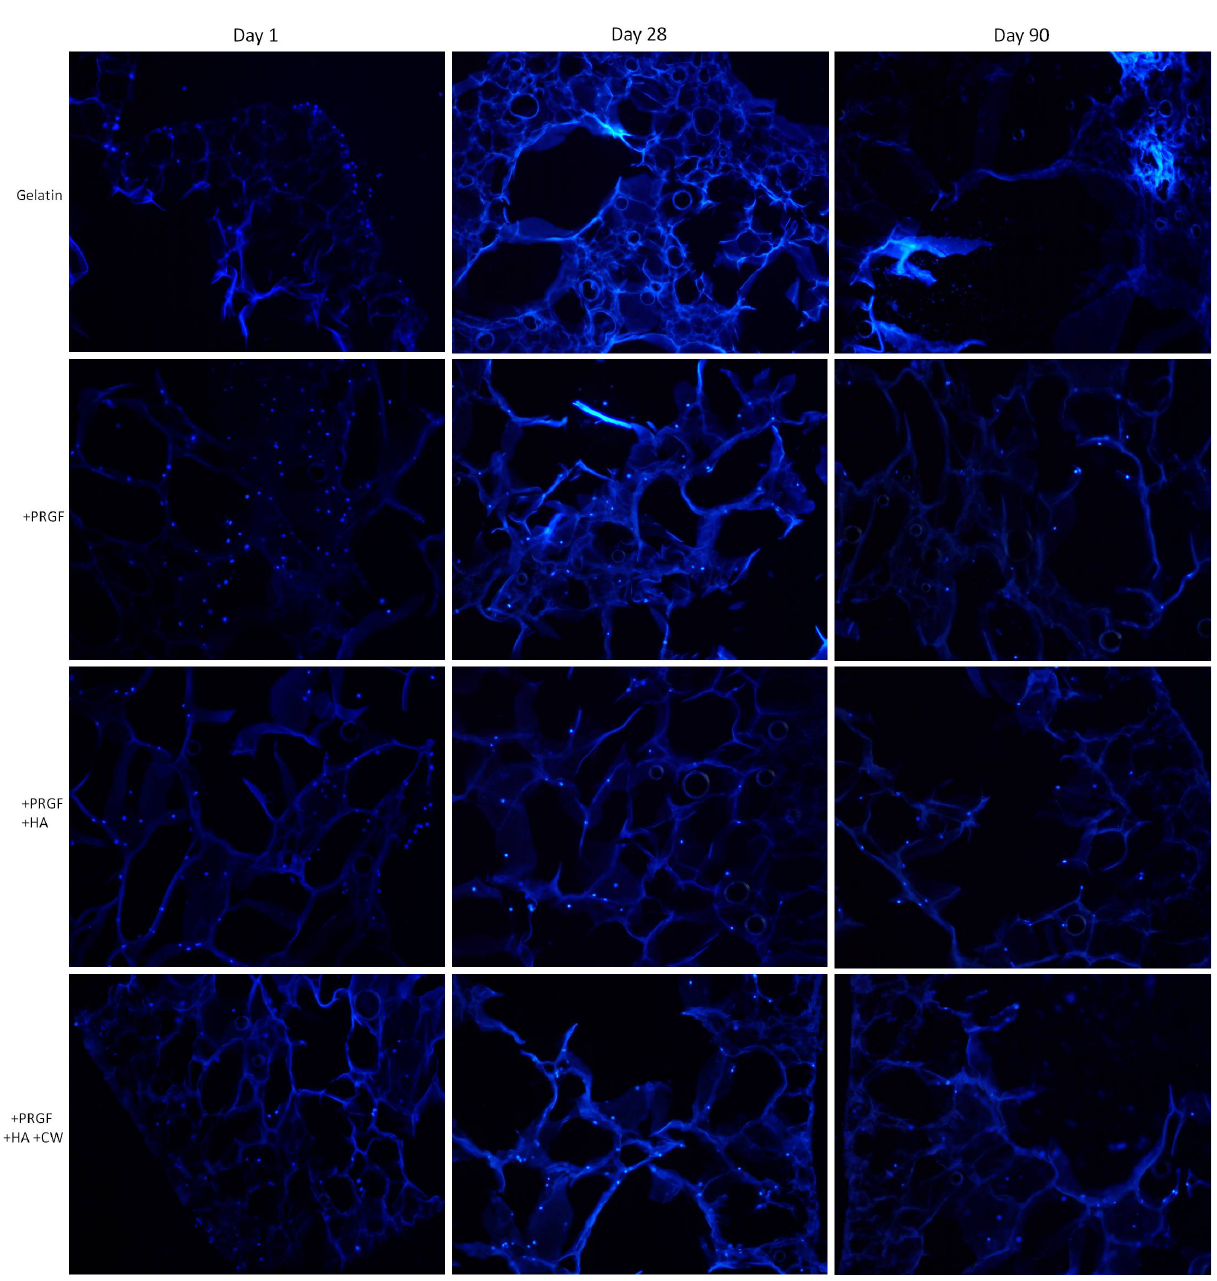
Figure 7. DAPI staining of post cross-linked scaffolds with MG-63 cells for 1, 28, and 90 days. Images taken at 20×